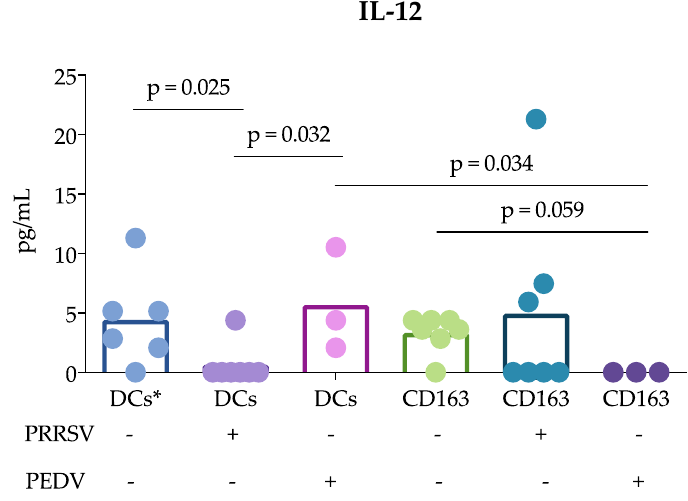
Figure 5. IL-12 production in cocultures of APCs with autologous CD3 + cells. Blood cDCs, splenic cDCs and CD163 + cells were cocultured with naïve CD3 + cells for 24 h, and cytokine production was evaluated by ELISA. The bars represent the mean, and each point represents one pig. Data were analyzed with the nonparametric Kruskal-Wallis test, and significant differences are indicated. DCs *, blood cDCs.